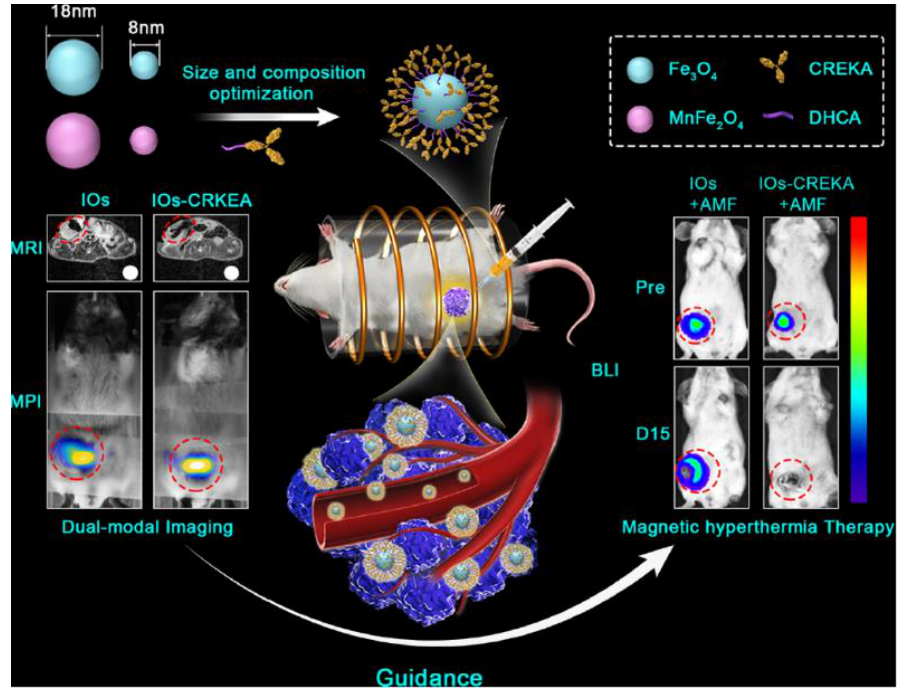
Figure 2. Schematic illustration of the developed CREKA-modified iron oxide (IO) nanoparticles (NPs) with different sizes and compositions for the potential application on dual-mode RI/MPI and magnetic hyperthermia therapy for the precise cancer imaging and therapy on a 4T1 breast tumour mouse model. Adapted with permission from [39]. Copyright (2019) American Chemical Society .